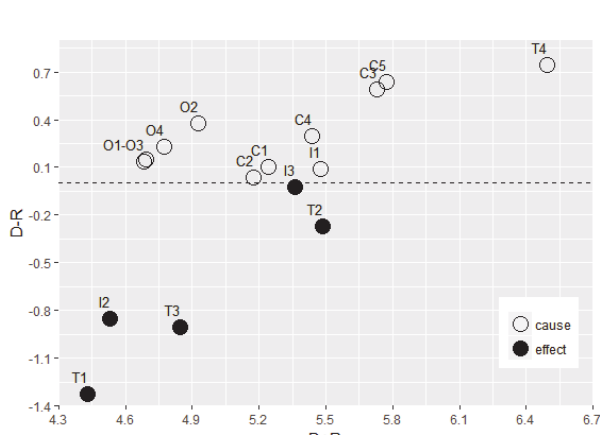
Fig. 8. Cause and effect Diagram, based in Unweighted Super Matrix of the Port